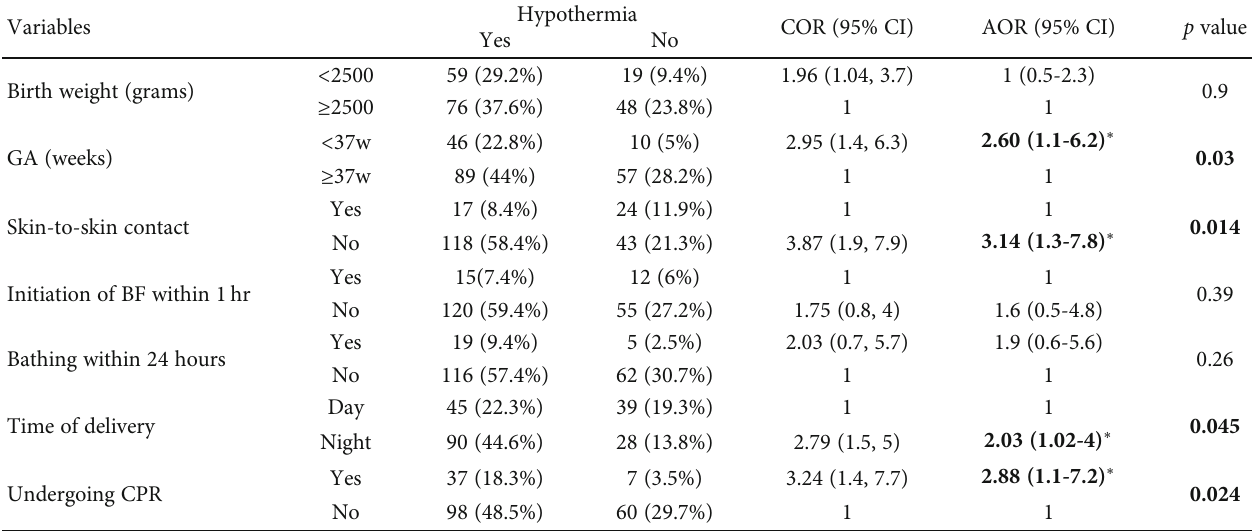
Table 5: Multivariate logistic regression analysis of factors associated with neonatal hypothermia in the NICU of Dessie Referral Hospital, Ethiopia, 2018 ( N = 202